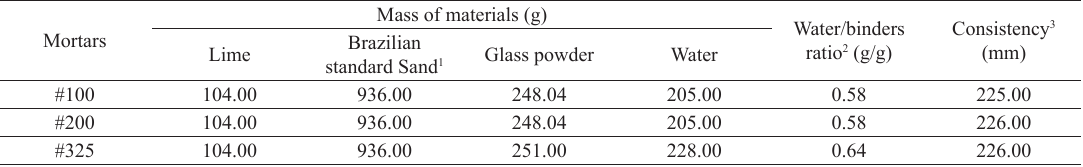
Table 1. Proportions of components in the mortar mixtures used for PAI with lime.